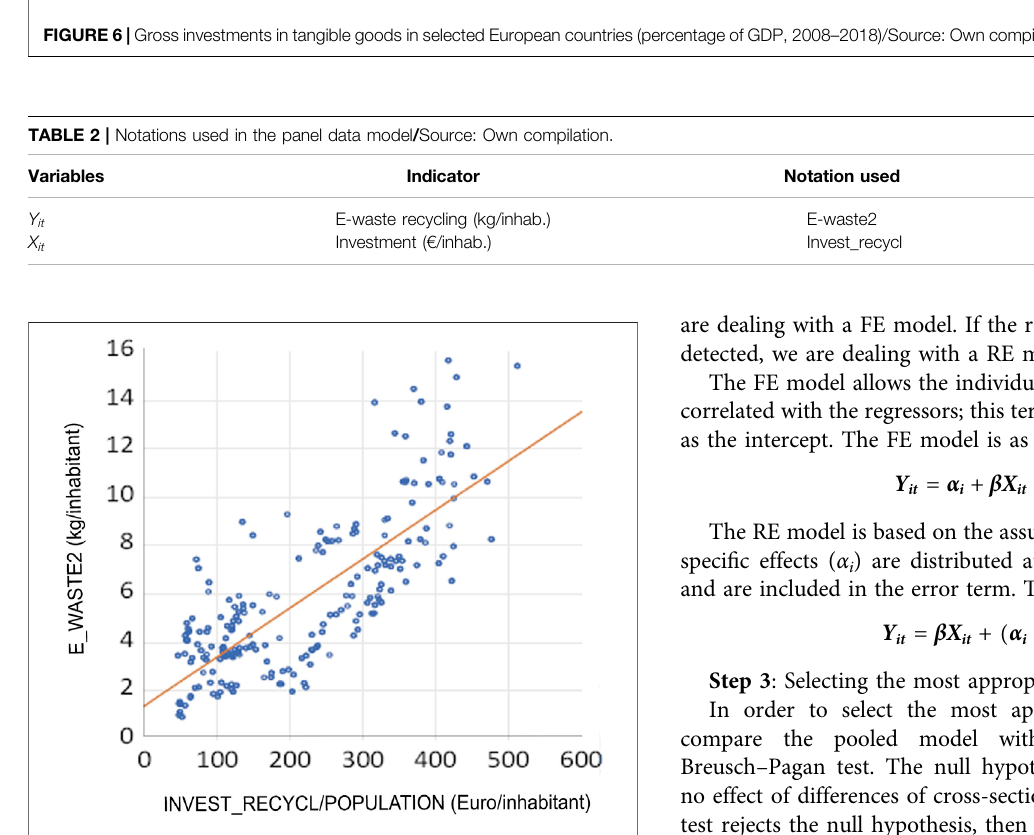
FIGURE 7 | Scatter plot of the series selected for the model (e-waste recycling and eco-investment) / Source: Own processing data from Eurostat.